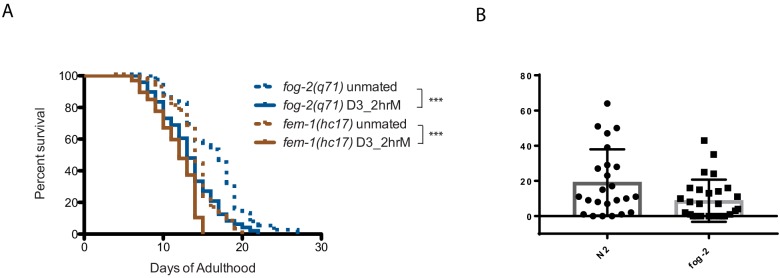
The presence of self-sperm protects the hermaphrodites from brief mating-induced death.(A) Both self-spermless fog-2(q71) and fem-1(hc17) hermaphrodites are susceptible to 2 hr mating on day 3 of adulthood. fog-2 unmated: 16.3 ± 0.7 days; mated: 13.4 ± 0.5 days, p=0.0010. fem-1 unmated: 14.2 ± 0.4 days; mated: 11.7 ± 0.3 days, p<0.0001. (B) Young N2 hermaphrodites’ resistance to brief mating-induced death is not due to low mating efficiency. Total male progeny from 2 hr mated N2 were counted (we only counted male progeny because we did not want to include progeny from self-fertilization. 2x male progeny from mated N2 hermaphrodites is a good estimate of the total number of cross-progeny) as well as total progeny (fog-2 does not have self sperm, so all the progeny produced after mating are cross-progeny) from 2 hr mated fog-2 hermaphrodites (All hermaphrodites were mated on Day 3 of adulthood). Mated N2 hermaphrodites produce at least two-fold more male progeny than total progeny produced by mated fog-2. Therefore, potentially more male sperm and seminal fluid were transferred to N2 hermaphrodites. Still, young N2 are resistant to brief mating-induced death, suggesting that young N2 hermaphrodites’ resistance to brief mating-induced death is not due to lower mating efficiency or the transfer of less male sperm or seminal fluid.